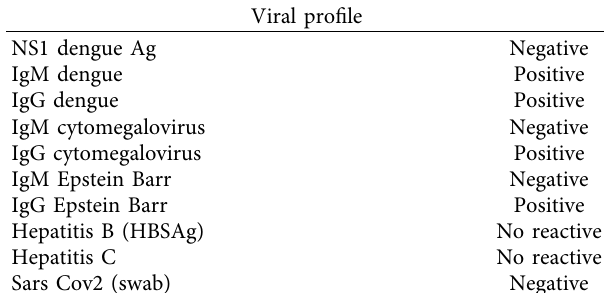
Table 1: Admission laboratory. Table 2: Infectious viral